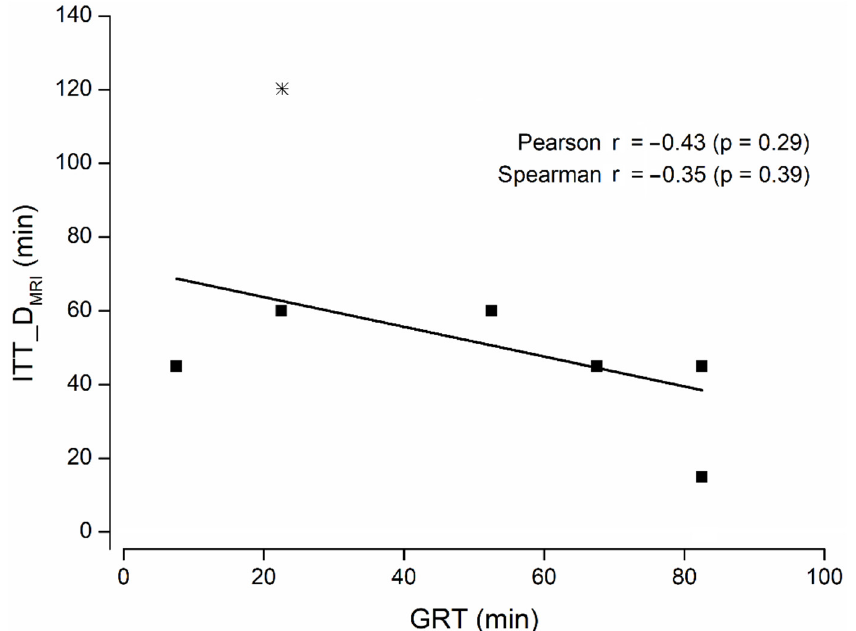
Figure 2. ITT_D by MRI related to GRT (n = 8). Capsule disintegration in the colon is highlighted as a star (*). Correlation is marked by a bar; correlation coefficients and corresponding p -values are stated.